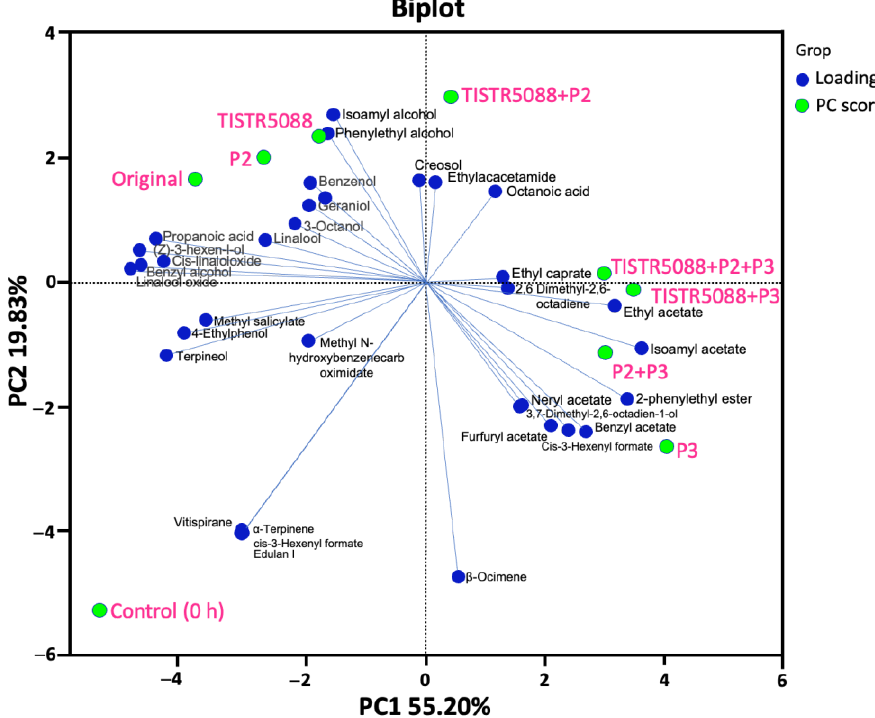
Figure 11. PCA biplot of the volatile compounds in the original and fermented MF-broth by S. cerevisiae TISTR 5088, W. anomalus P2 and C. rhodanensis P3, with single and co-fermentation at 120 h.